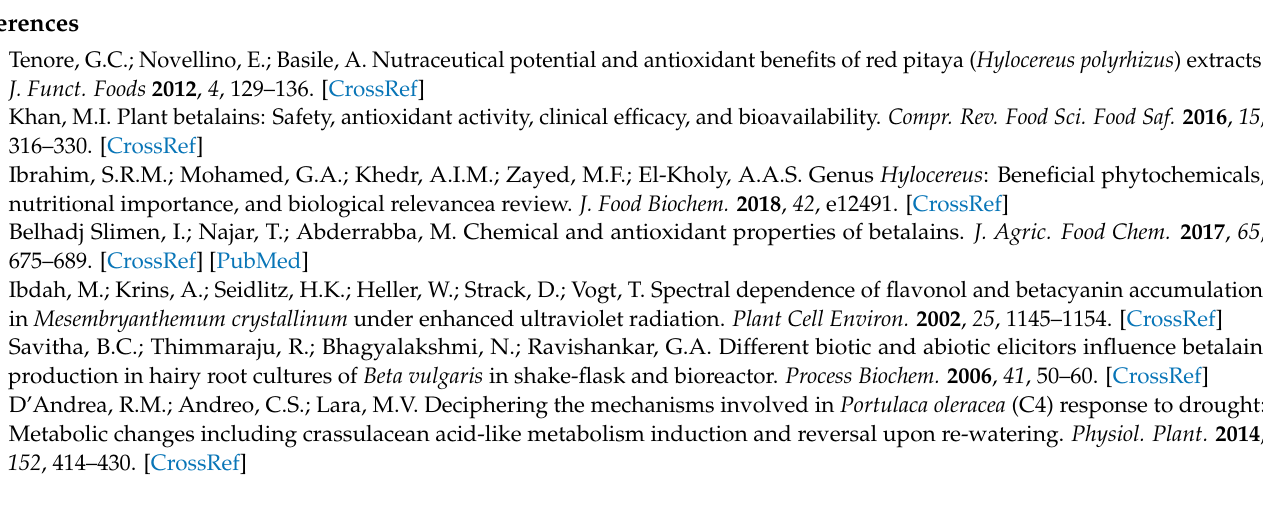
infected. Table S1: Th e accession numbers of genes in this study. Table S2: All primers used in this study. Table S3: 53 candidate genes in pitaya. Table S4: Amino acid sequence similarities